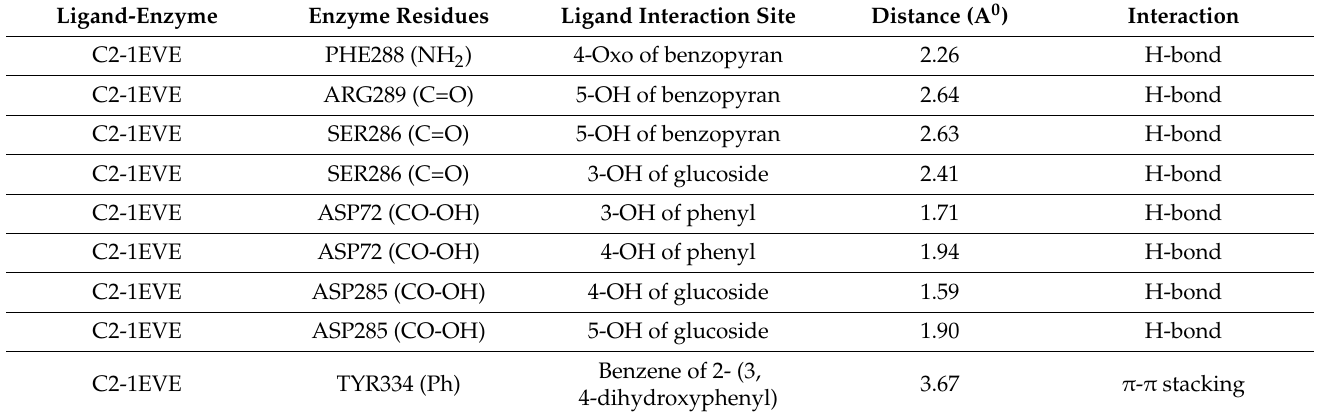
Table 3. The interactions between the ligand and the enzyme, bonds formed and bond